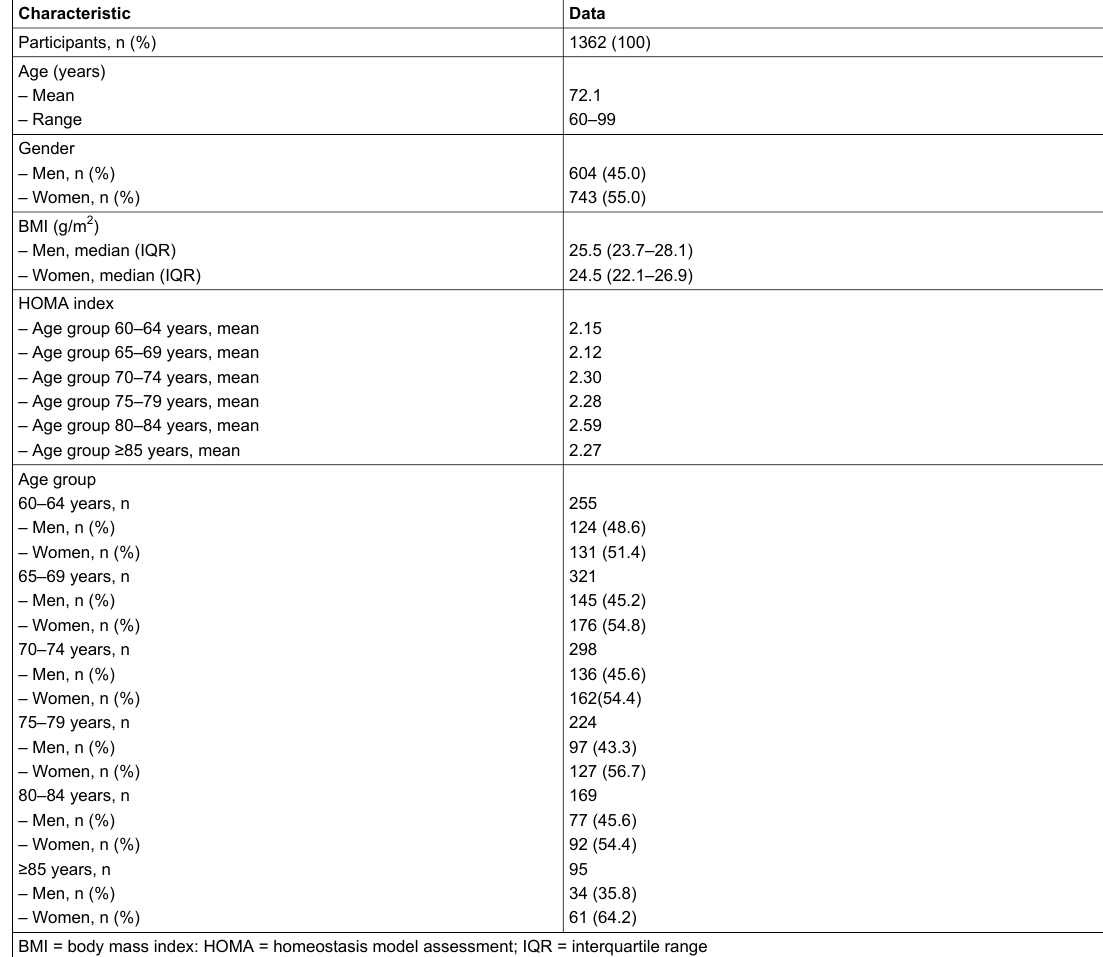
Table 1: Demographics and number of participants in each age group for the homeostasis model assessment [13].